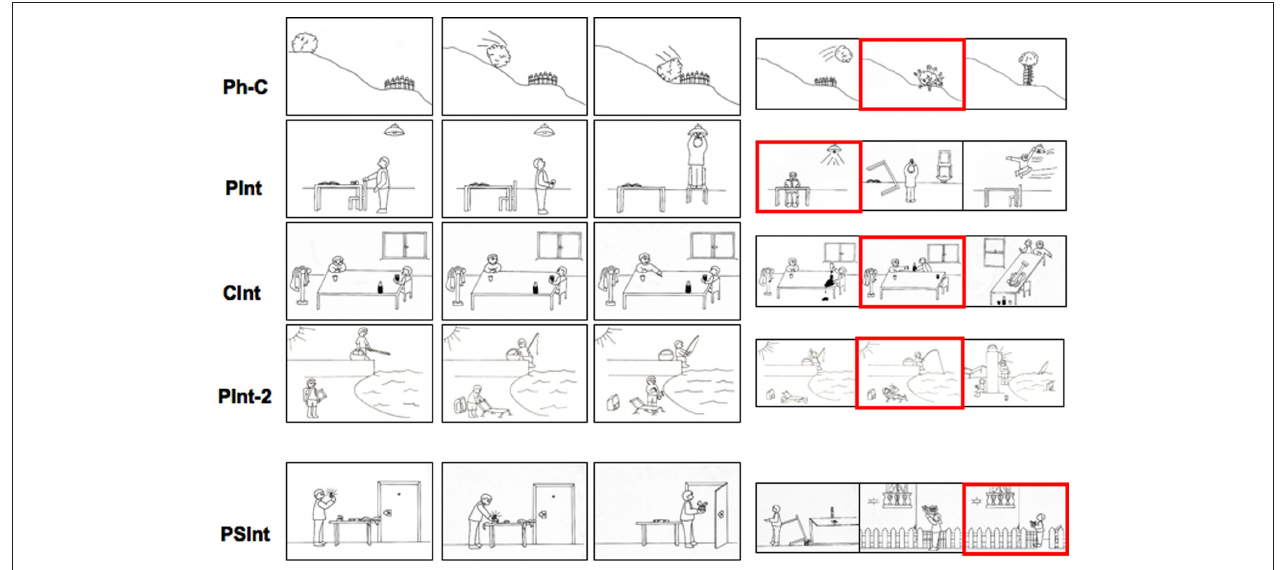
FIguRe 4 | Activation paradigm. One trial for each experimental condition is shown. Red square indicates the correct answer.